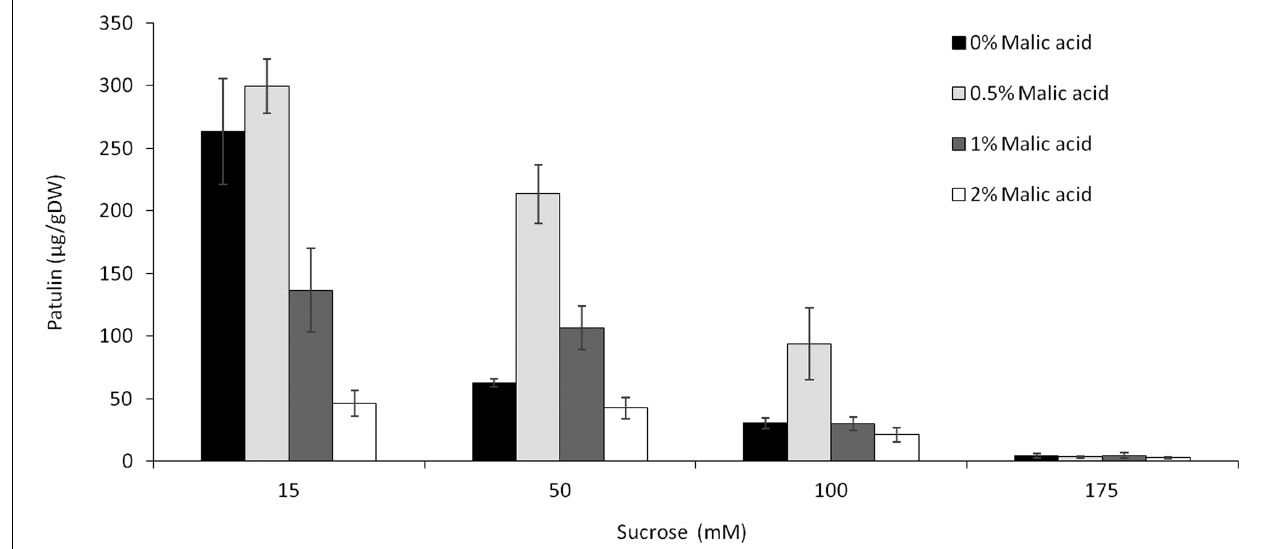
FIGURE 5 | Effect of the combination of sucrose and malic acid in the SM media on patulin accumulation by P. expansum . Solid SM-media at initial pH 5.0 amended with concentrations of 15–175 mM sucrose in combination with 0–2% concentrations of malic acid. SM plates were inoculated with 100 µ l of a 10 6 spore/ml and patulin was evaluated 3 days post-inoculation. Five 10-mm-diameter disks were sampled from five independent culture plates. Average values ( ± SE) of five replicates are reported. Experiments were repeated three times and results of a single representative experiment are